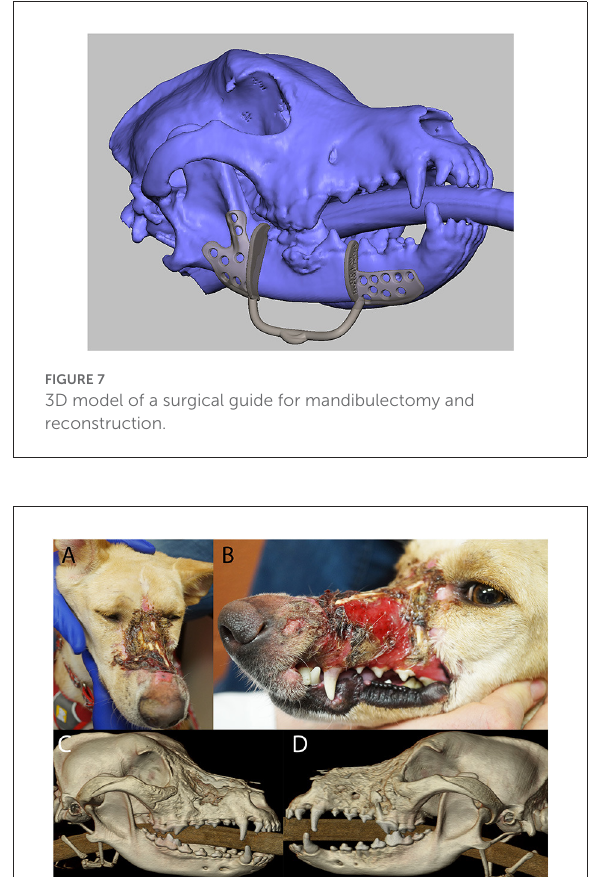
FIGURE6 Computer Aided Design (CAD) of a mandibular implant shown in FreeForm Plus (3D-Systems, Rock-Hill, USA) (A) , 3D printed surgical guide for mandibulectomy and reconstruction in the print bed (B) , and 3D printed, patient-specific titanium mandibular reconstruction implant after post-processing (C) .